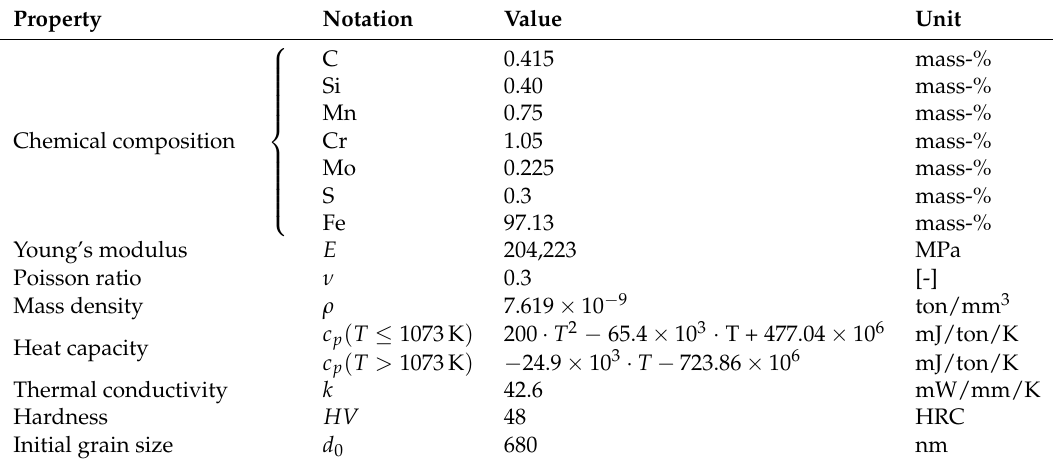
Table 1. Chemical composition, mechanical and physical properties of quenched/tempered AISI 4140